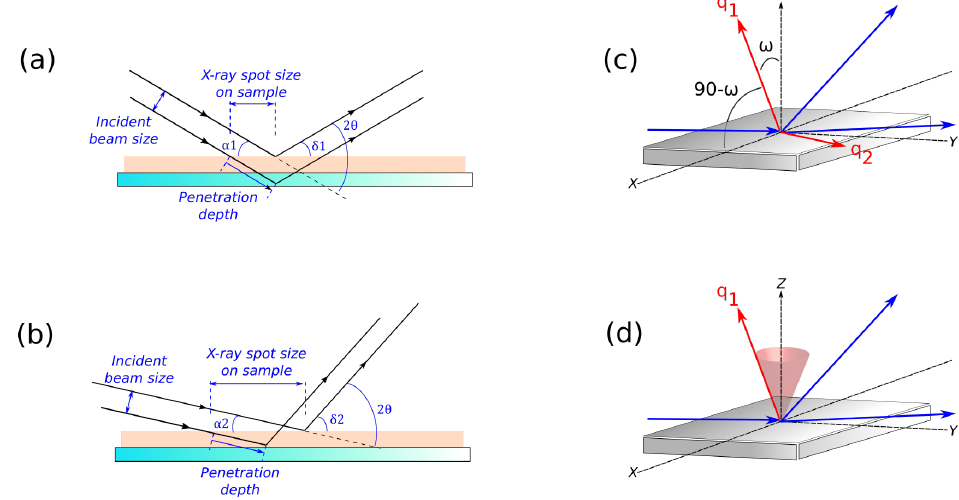
Figure 5. Illustration of GIXD ( a – b ) and the “hole” in GIXD data ( c – d ). ( a ) Illustration of XRD done at a high incident angle on a thin film. Note that the beam spot is small and that the XRD may penetrate through the thin sample. ( b ) The same measurement but done at low incident angle, causing the beam spot to widen, hence reducing X-ray flux on the sample and reducing X-ray damage. In this configuration, X-rays will also be less likely to penetrate through the sample, resulting in higher signal and reduced background, making this configuration very suitable for thin-film samples. ( c ) The extreme crystallite orientations that can be measured at a fixed incoming angle. These two extremes are defined by outgoing beam parallel and perpendicular to sample surface. ( d ) The cone subtended by ω , within which crystallite orientations will not satisfy Bragg condition, producing a hole in the